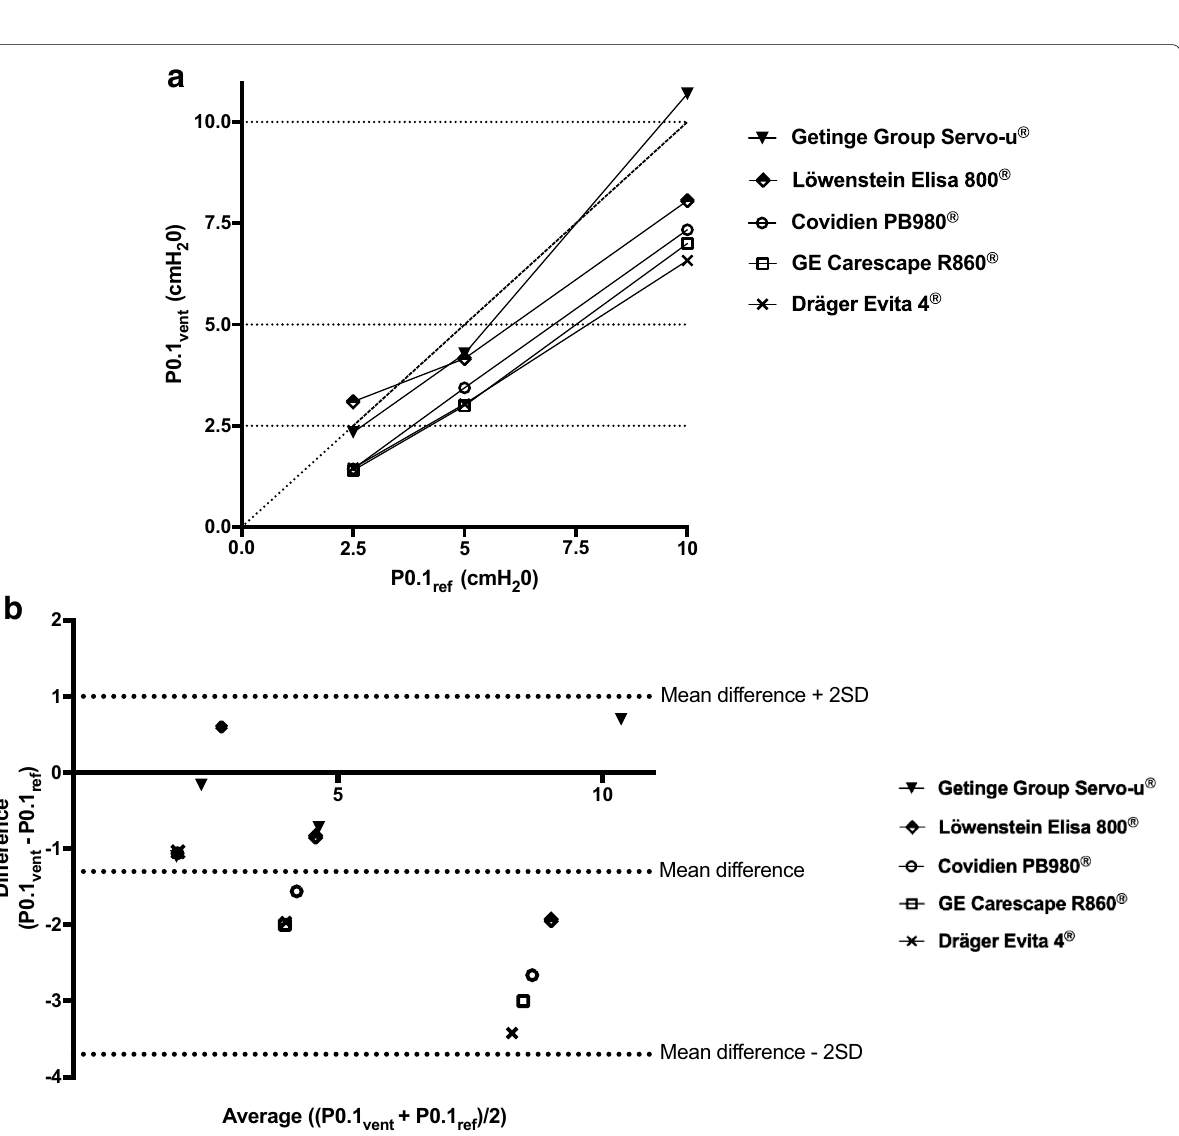
Fig. 2 Accuracy of automatically measured P0.1 displayed on the ventilator screen (P0.1 vent ). a Correlation between P0.1 vent and reference P0.1 (P0.1 ref ). The horizontal dotted lines represent P0.1 reference values of 2.5, 5 and 10 cm H 2 O, respectively. The diagonal dotted line represents the identity line ( y x ). b Bland and Altman plots of differences between P0.1 vent and P0.1 ref versus their mean. The dotted lines represent the mean bias = and the limits of